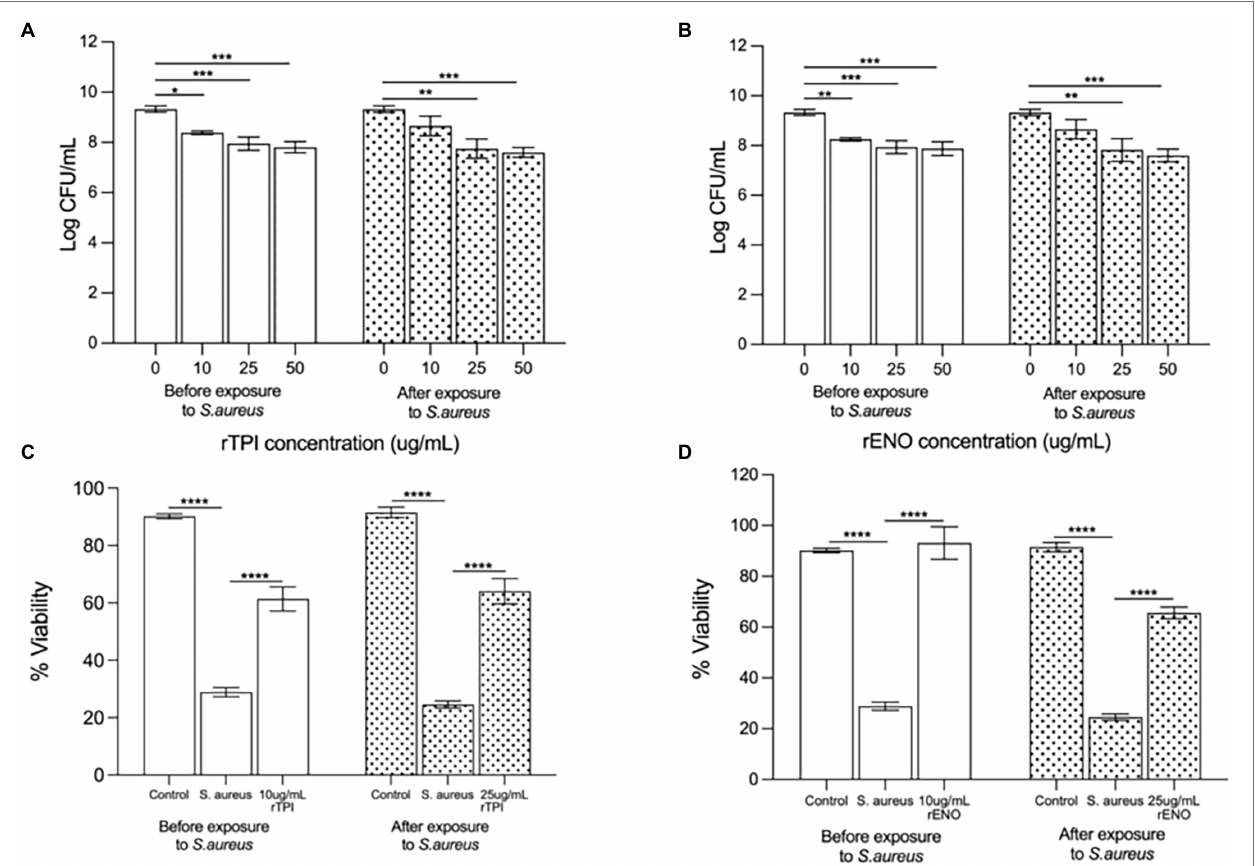
FIGURE 5 | (A) Recombinant TPI (rTPI) and (B) recombinant ENO (rENO) added prior to addition of the pathogen inhibited staphylococcal adhesion to keratinocytes in a dose dependent manner (* p = 0.0238, p = 0.0107 and p = 0.0030 for 10, 25 and 50 ug/mL of rTPI respectively and ** p = 0.0063, *** p = 0.0095 and *** p = 0.0052 for 10, 25 and 50 ug/mL of rENO respectively). However, when added subsequent to exposure of cells to S. aureus , (A) rTPI and (B) rENO only 25 and 50 ug/mL inhibited S.aureus adhesion (** p = 0.0007 and *** p < 0.0001 for 25 and 50 ug/mL of rTPI respectively and ** p = 0.0012 and *** p < 0.001 for 25 and 50 ug/mL of rENO respectively). Recombinant